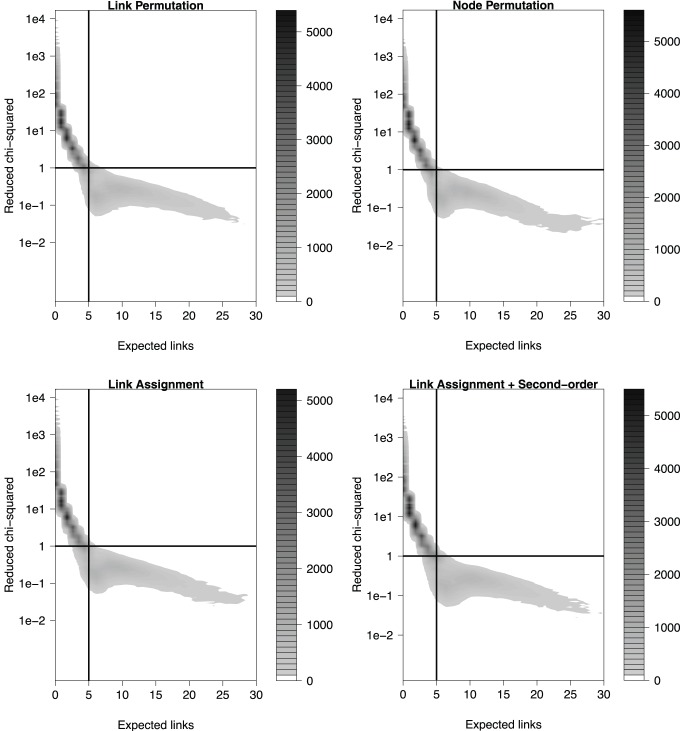
Normality test of the null model distribution.Values of the reduced chi-squared test of normality are plotted against the expected number of links for all four methods using randomized KEGG pathways. The normality criterion is generally only violated for low numbers of expected links. The horizontal line represents the threshold used for normality (chi-squared = 1), and the vertical line is at expected number of links = 5. The number of points is indicated by the density, lighter colors are lower density.